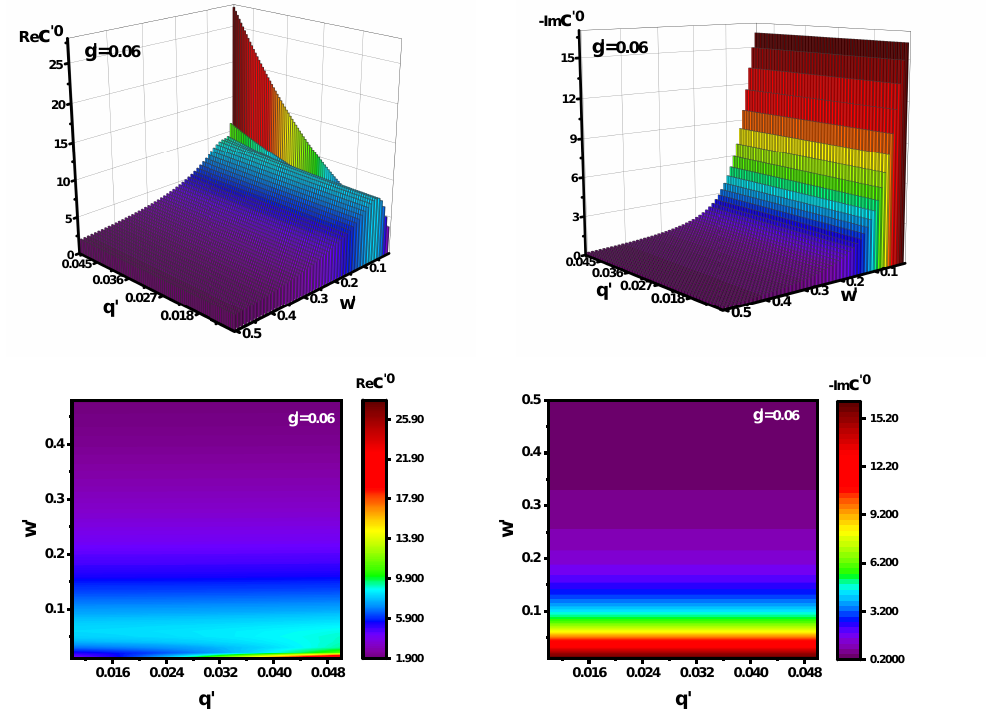
Figure 3. 3D bar and contour plot of the real and imaginary parts of χ for γ (cid:48) =